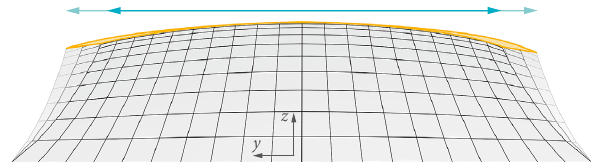
Figure 14: Increase of the width of the shell at its